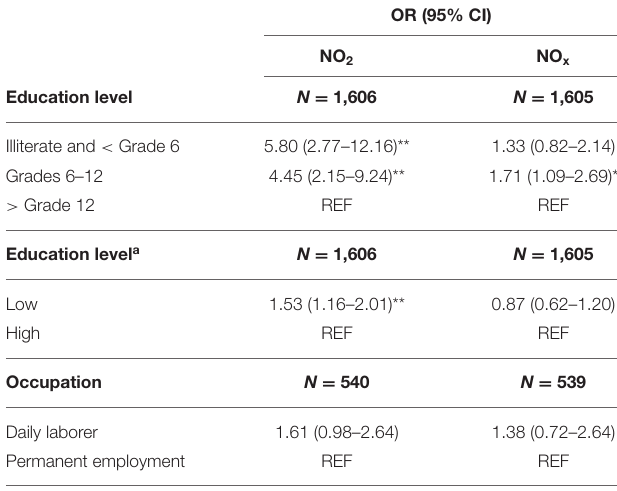
TABLE 3 | Odds of being exposed to levels of NO 2 and NO x above 20 µ g/m 3 associated with education level and occupation among women in the Adama Mother and Child